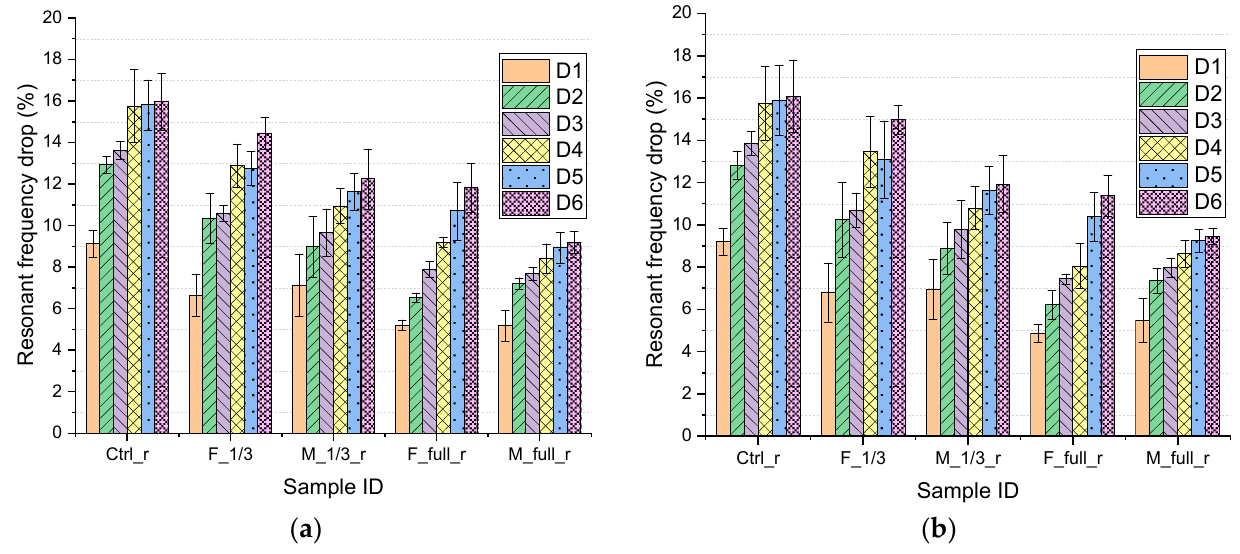
Figure 7. Resonant frequency for beams at different damage degree D i ( i = 1, . . . , 6) measured using ( a ) hammer percussion method ( b ) modified chain-drag method.